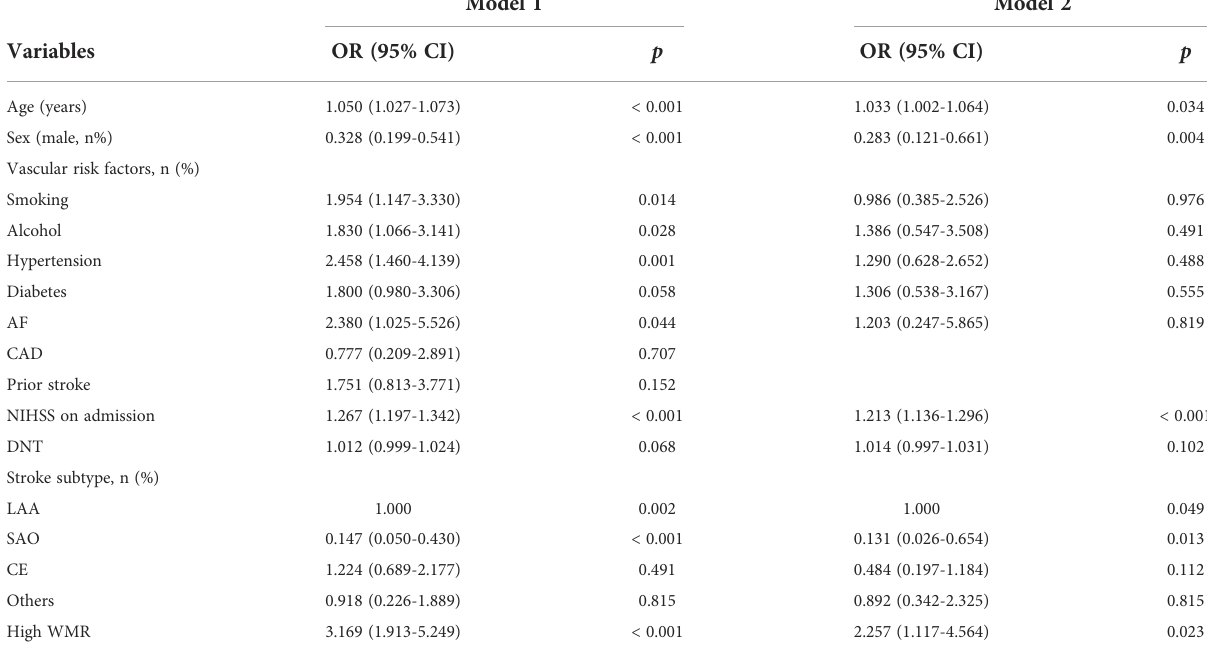
TABLE 3 Univariate and multivariate logistic regression analysis for 3-month poor outcome.